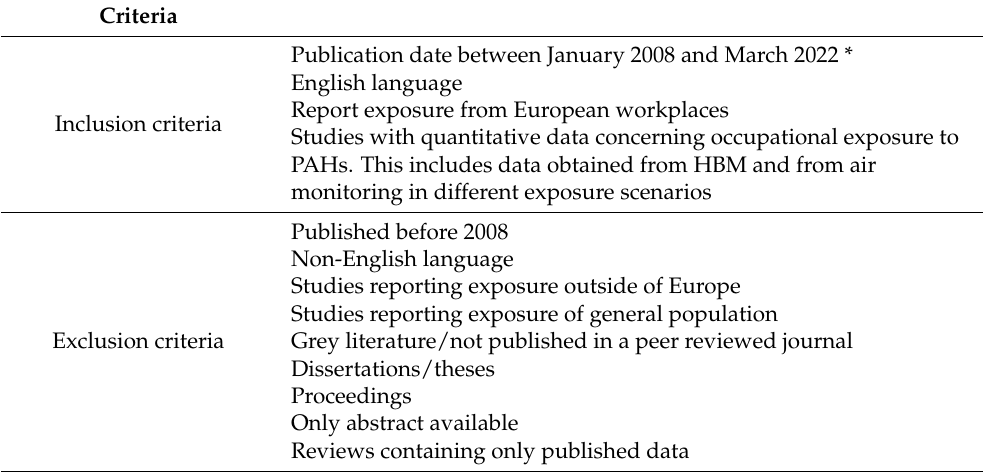
Table 2. Inclusion and exclusion criteria for the literature